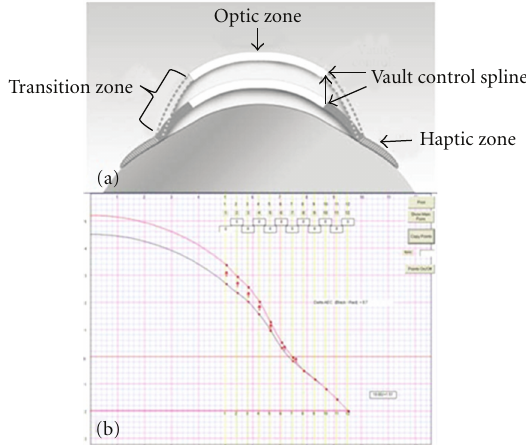
Figure 3: (a) Schematic diagram of a PROSE device illustrating how transitional zone is used to allow for vault independent of base curve. (b) Screen shot of the CAD/CAM system used for PROSE device